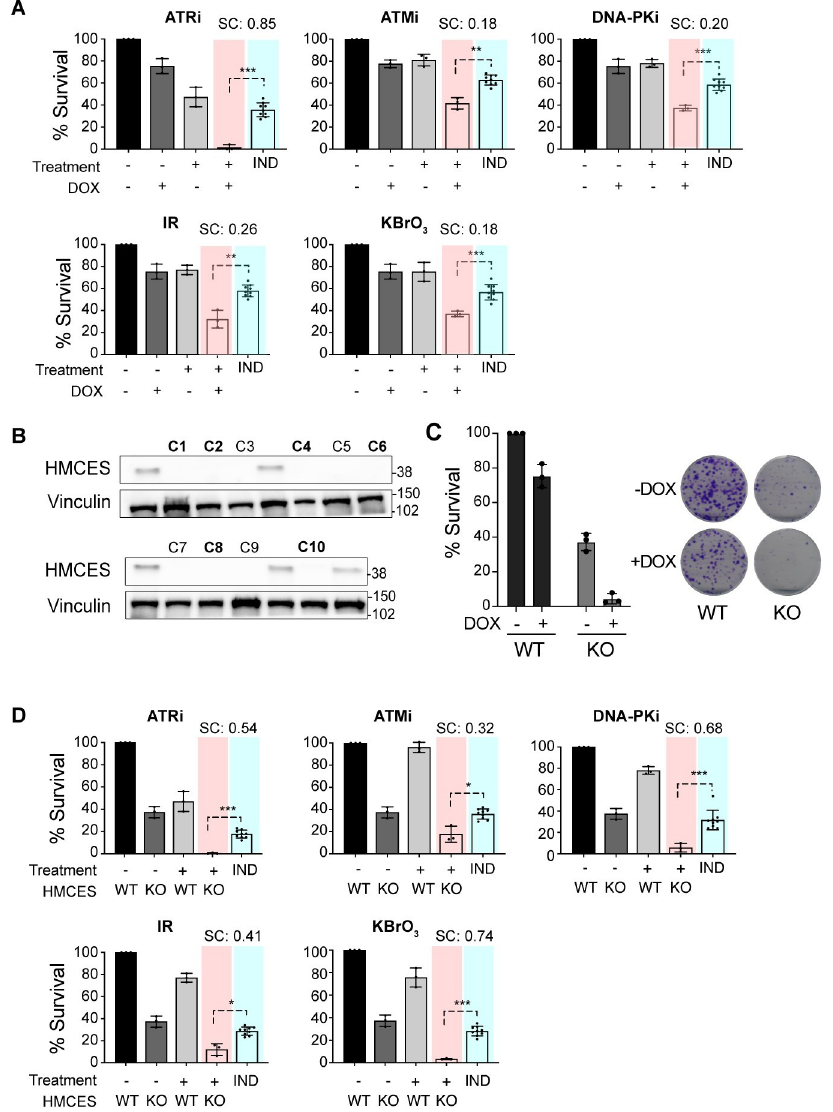
Fig 5. A3A expression sensitizes to DNA damage and HMCES loss. ( A ) Clonogenic survival measured by the colony formation assay in LXF-289 A3A cells after exposure to the indicated small molecule inhibitor, IR (5 Gy), or treatment with 0.1 mM KBrO 3 with or without DOX (0.125 ug/ml) to induce A3A expression. ( B ) HMCES western blot of lysates from LXF-289 A3A HMCES WT and KO clones. Vinculin was used as a protein loading control, and molecular mass is indicated in kilodaltons. ( C ) Clonogenic survival assay of LXF-289 A3A HMCES WT and KO cells upon overexpression of A3A by DOX. ( D ) Clonogenic survival assay comparing HMCES WT and KO cells after treatment with the indicated small molecule inhibitor, exposure to IR (5 Gy), or treatment with 0.1 mM KBrO 3 with or without DOX to induce A3A expression. For panels A and D, the “IND” column shows a Bliss independence model of additive activity of the 2 treatments, against which the combined treatment is tested (using t test, 2-tailed) to estimate synergistic activity [66]. Mean and SD are shown in all graphs. � , p � 0.1, �� , p � 0.05 ��� , p � 0.01. Each experiment was repeated 3 times, and primary numerical data are provided in S5 Data. A3A, APOBEC3A; DOX, doxycycline; IR, ionizing radiation; KO, knockout; SC, synergy score; SD, standard deviation; WT,